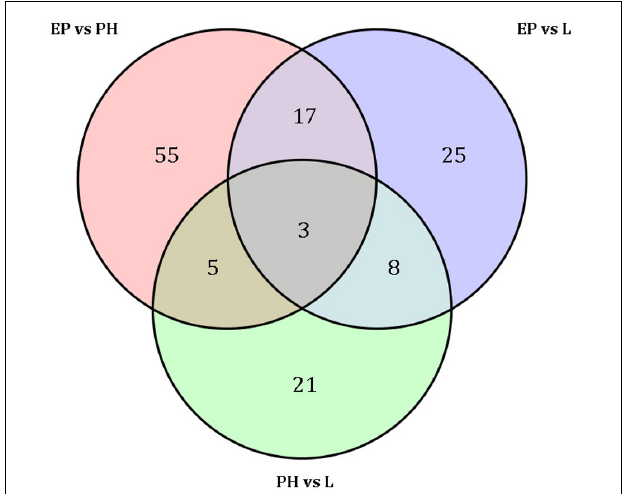
FIGURE 3 | Venn diagram shows the number of differentially expressed miRNAs among three embryonic